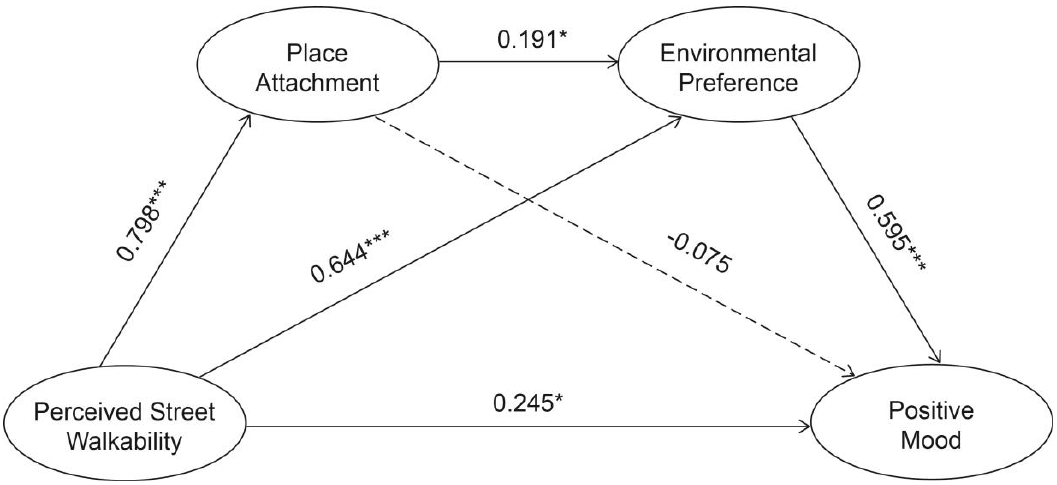
Figure 4. Standardized coefficients in the structural equation model. Note: * p < 0.05; *** p < 0.001.